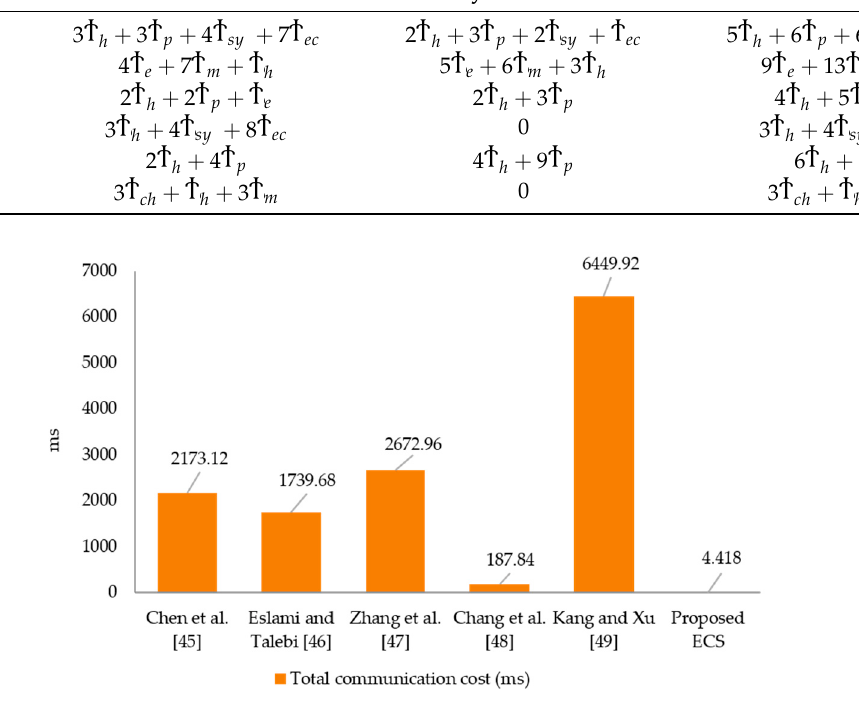
Figure 4. Total communication cost (ms).